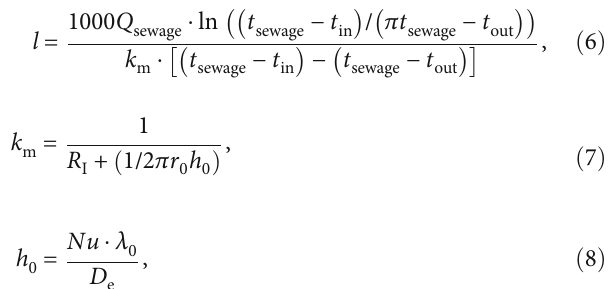
Figure 8: Comparison of the domestic sewage and outdoor monthly mean temperatures in